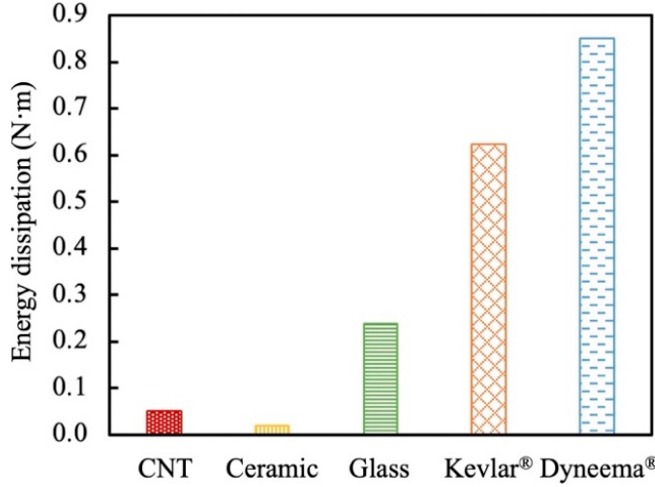
Figure 13. Comparison of energy dissipation of different fibers.